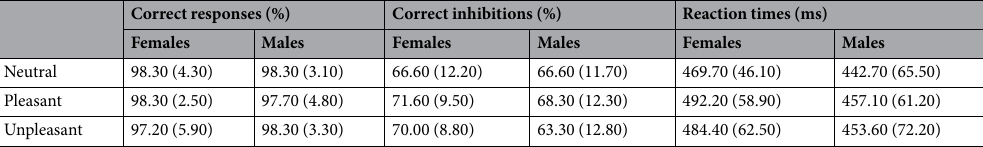
Table 1. Behavioral performance data in each condition: means and standard